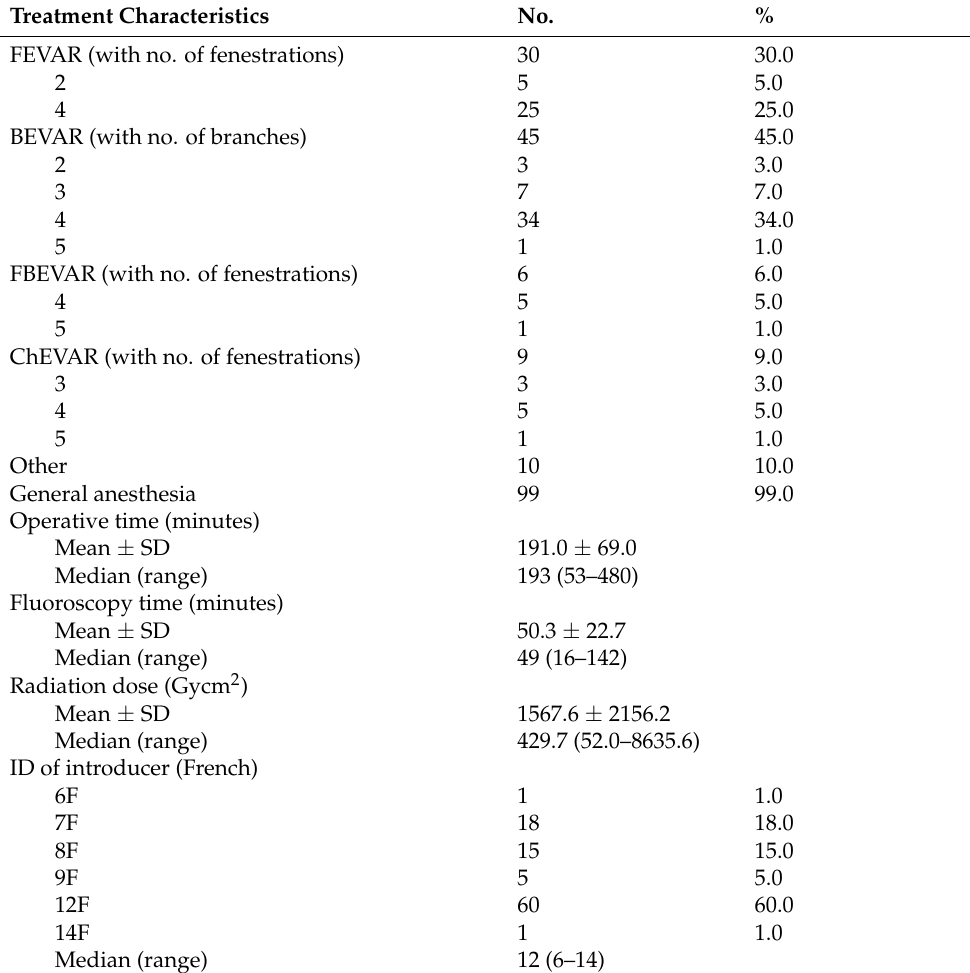
Table 4. Endovascular treatment